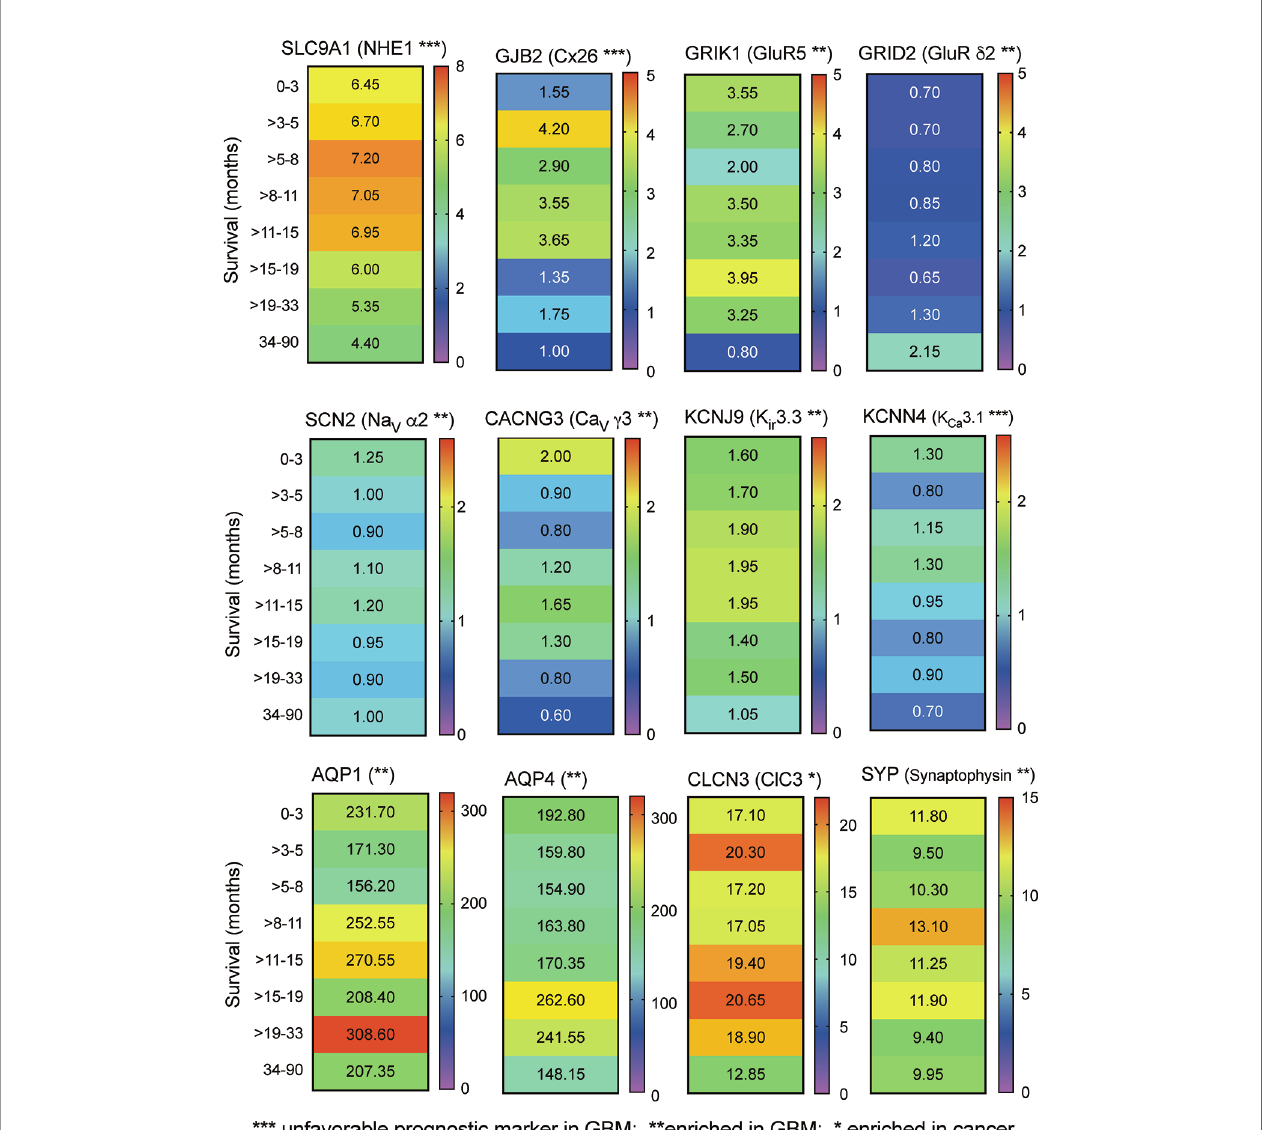
FIGURE 2 | Correlation between relative expression levels of key genes and patient survival. Heat maps summarizing the quantitative median levels of transcripts (FPMK, color bars) for 12 genes, for results banded into bins based on durations of patient survival. Results were calculated from TCGA data available in the Human Protein Atlas. Asterisks indicate relative prognostic values: *** increased transcript expression is an unfavorable prognostic marker in GBM; ** transcript levels are selectively enriched in GBM; * transcript levels are enhanced in